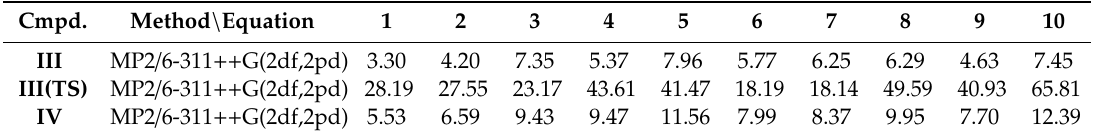
Table 1. The values of energy for the hydrogen bonding in dipyrromethene ( III and III ( TS )—for the optimized geometries and transition states, respectively) and in the dipyrromethane anion ( IV ), calculated with the following equations: ( 1 ) 6.4 × 10 3 × e − 3.1·d(HN) (Å); ( 2 ) 3.8 × 10 3 × e − 2.73 × d(HN) (Å); ( 3 ) − 5.554 × 10 5 × e − 4.12 × d(NN) (Å); ( 4 ) 186 × ρ b − 2.3 (eÅ 3 ); ( 5 ) 163 × ρ b (eÅ 3 ); ( 6 ) 0.448 × G b − 3.1